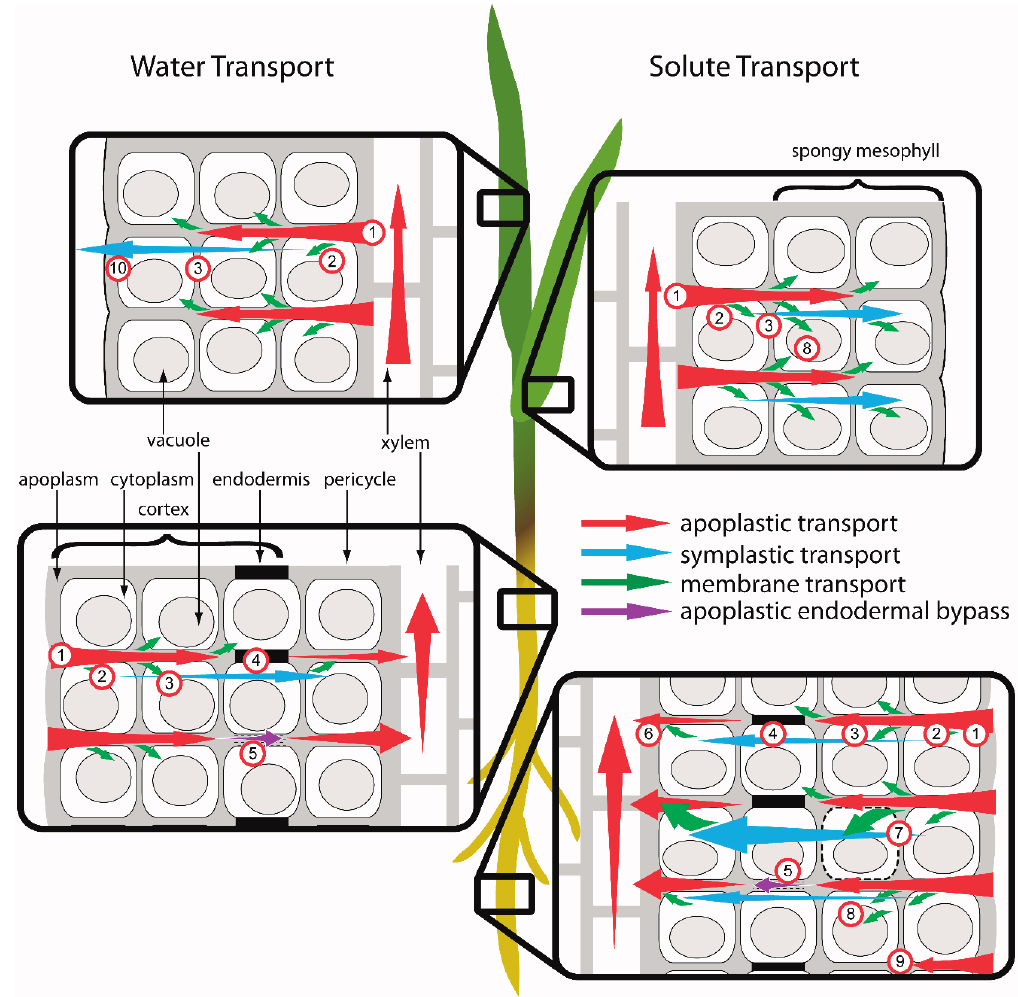
Figure 5. Modeled water and solute transport pathways in root and leaf tissue: (1) apoplastic transport; (2) membrane transport; (3) symplastic transport between cells; (4) symplastic transport across the endodermis; (5) apoplastic endodermal bypass flow; (6) xylem loading; (7) membrane damage; (8) sequestration to vacuole; (9) sorption to apoplastic sites; and (10) evaporation in spongy mesophyll. For clarity, plasmodesmata, which span cell walls